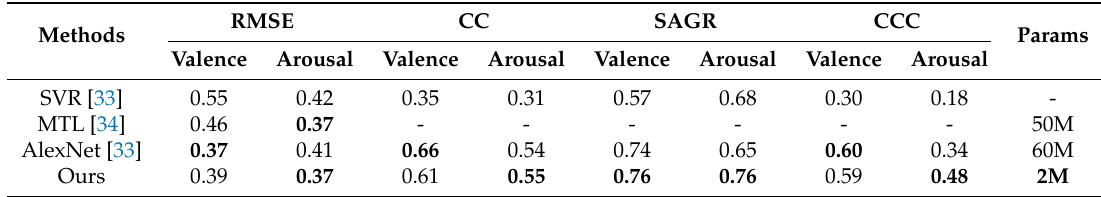
Table 4. Comparison of our method with other methods in AffectNet validation set for valence and arousal estimation (the bold value indicates the best